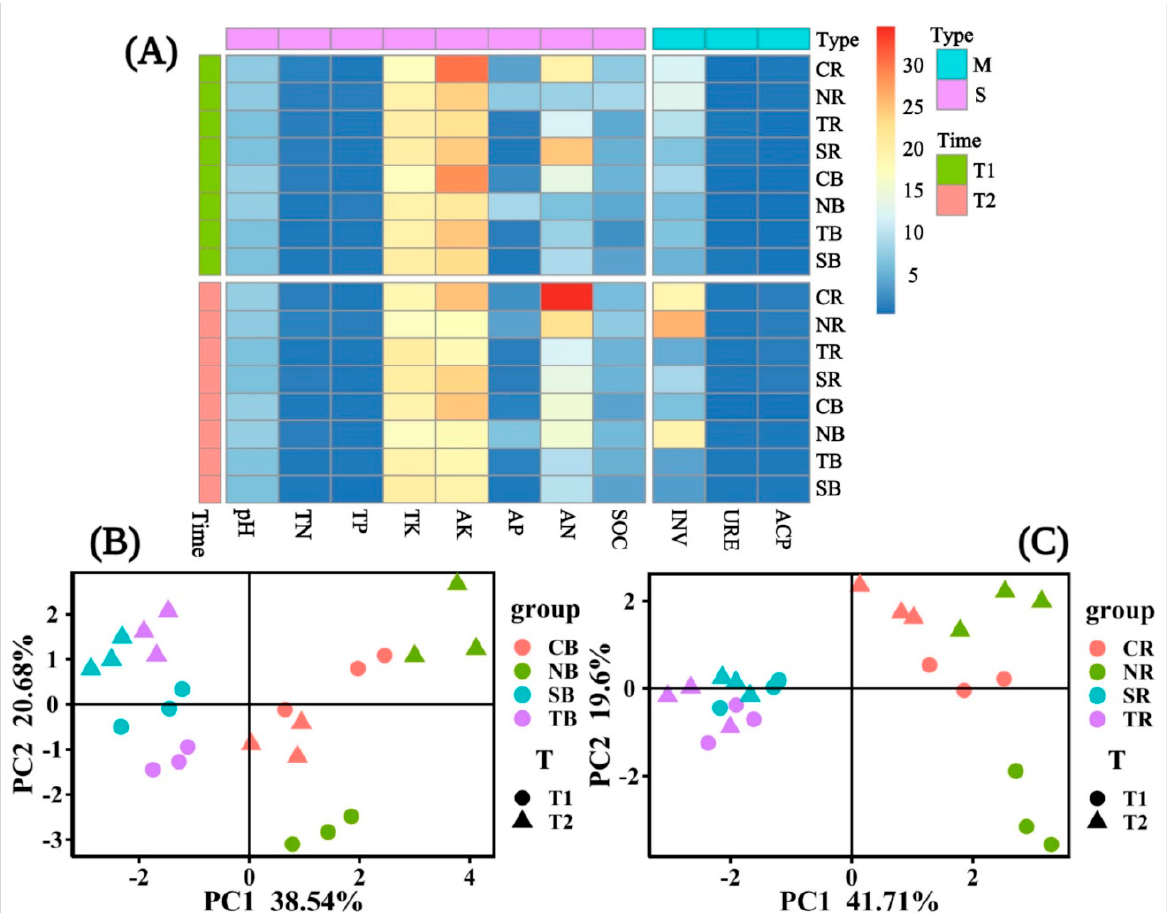
Figure 4. The heat map showed the combinations of soil enzyme (M) and soil properties (S) under different emergence phases (T1 for early phase and T2 for late phase) within the riparian zones of the Three Gorges Dam Reservoir, China ( A ). Principal component analysis (PCA) showed the difference in soil properties in T1 and T2. The factor loading of PCA axes 1 and 2 explained 59.22% and 61.31% of the total variation for the bulk soil and rhizosphere soil in ( B , C ), respectively. Note: Abbreviations in the figure define as pH value (pH), available potassium (AK), total potassium (TK), alkali hydrolyzed nitrogen (AN), available phosphorus (AP), soil organic contents (SOC), total nitrogen (TN), total phosphorus (TP), acid phosphatase (ACP), invertase (INV), and urease (URE), bulk soil (B), rhizosphere soil (R), Cynodon dactylon (C), Hemarthria altissima (N), Salix matsudana (S), Taxodium distichum (T).